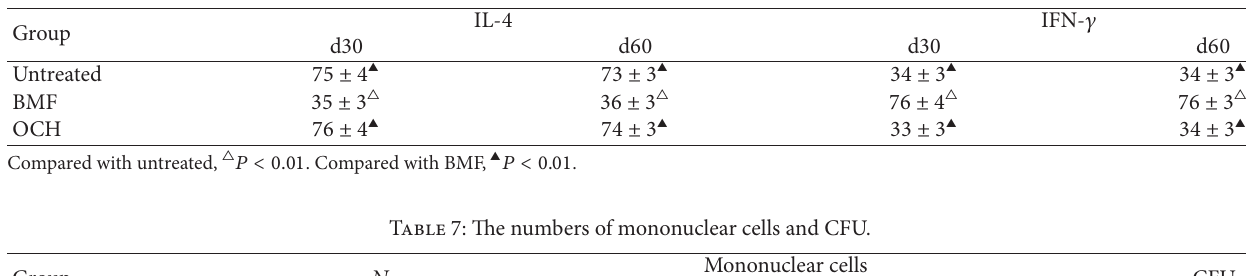
Table 6: Serum level of IL-4 and IFN- 𝛾 (pg/mL, 𝑛 = 7 ).